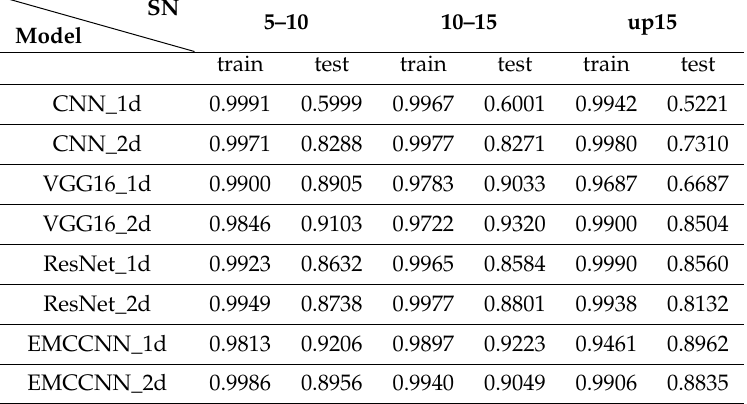
Table 3. Classification accuracy of different network models (1D and